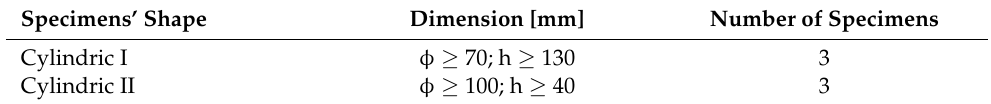
Table 1. Specimens produced, per formulation.